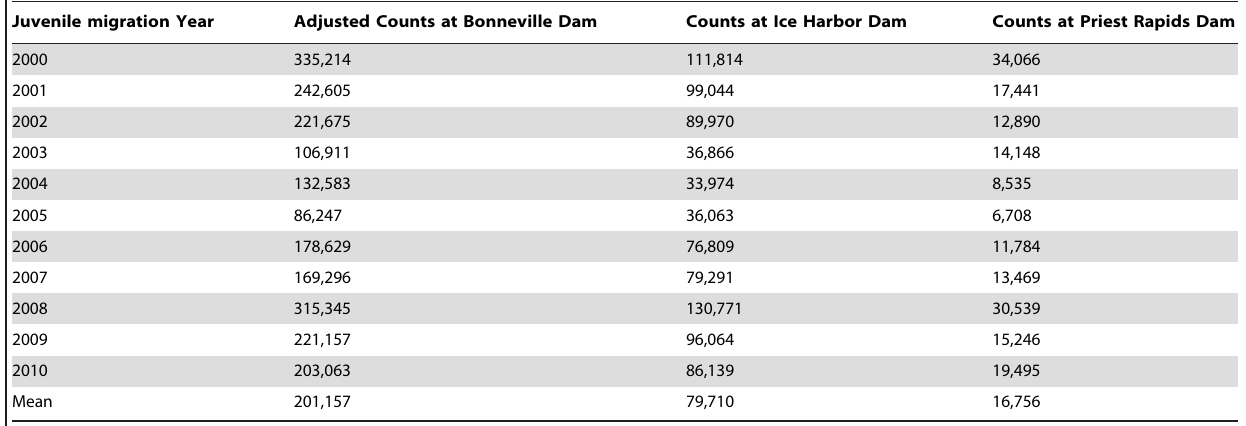
Table 2. Chinook salmon adult return